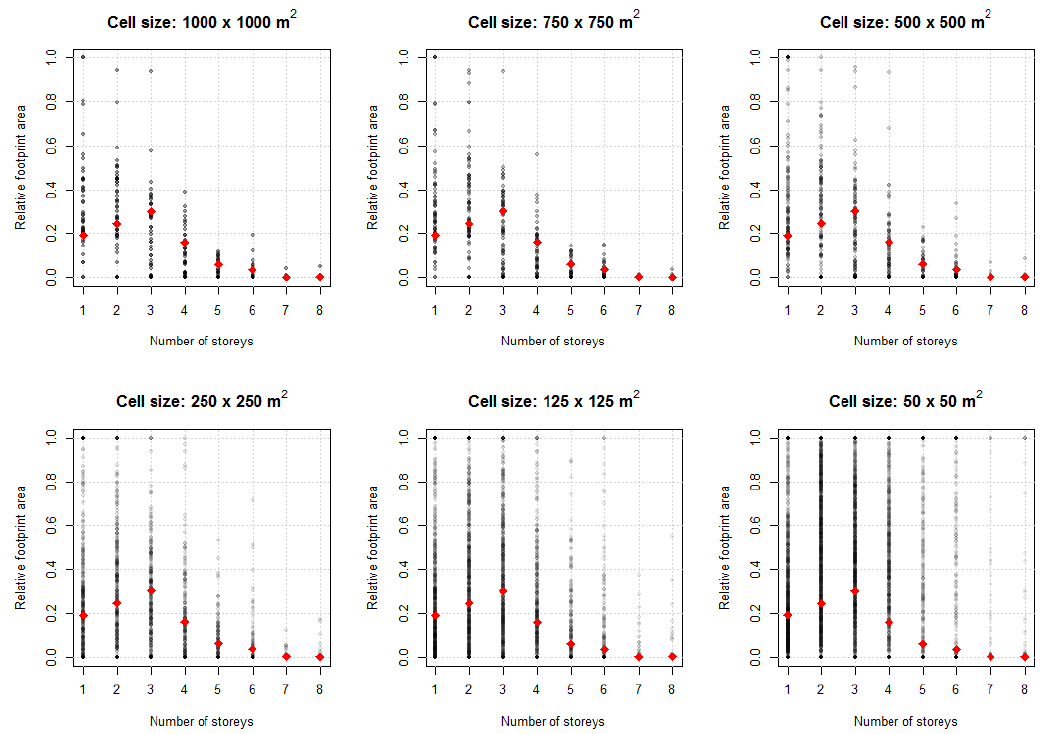
Figure 11. Relative footprint areas of buildings of each height class in every grid cell, for grids with six different spatial resolutions. Red rhombuses represent fractions at municipality level.